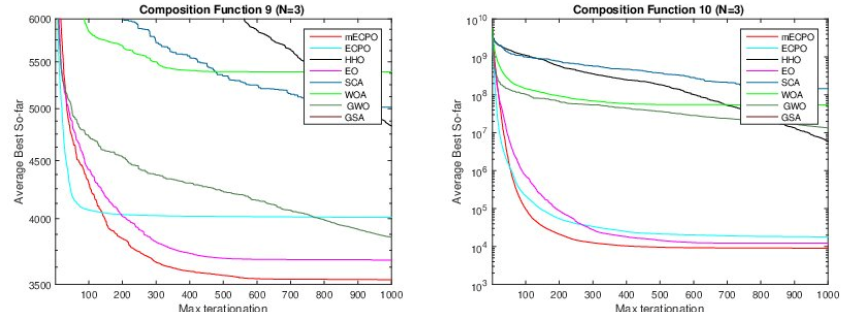
Figure 5. The convergence curves of the MECPO and the counterparts achieved on CEC’17 functions with Dim = 30.